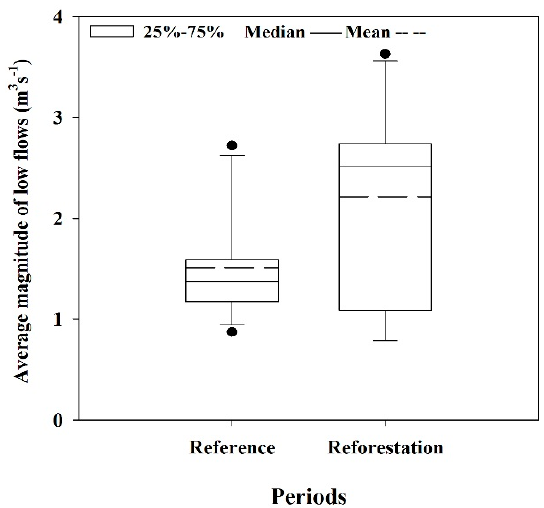
Figure 6. Reference period vs. reforestation period: comparison of the average magnitude of low flows.